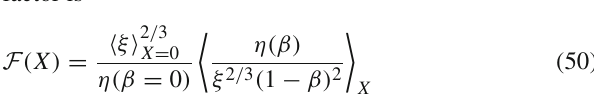
. The black points on the solid 0